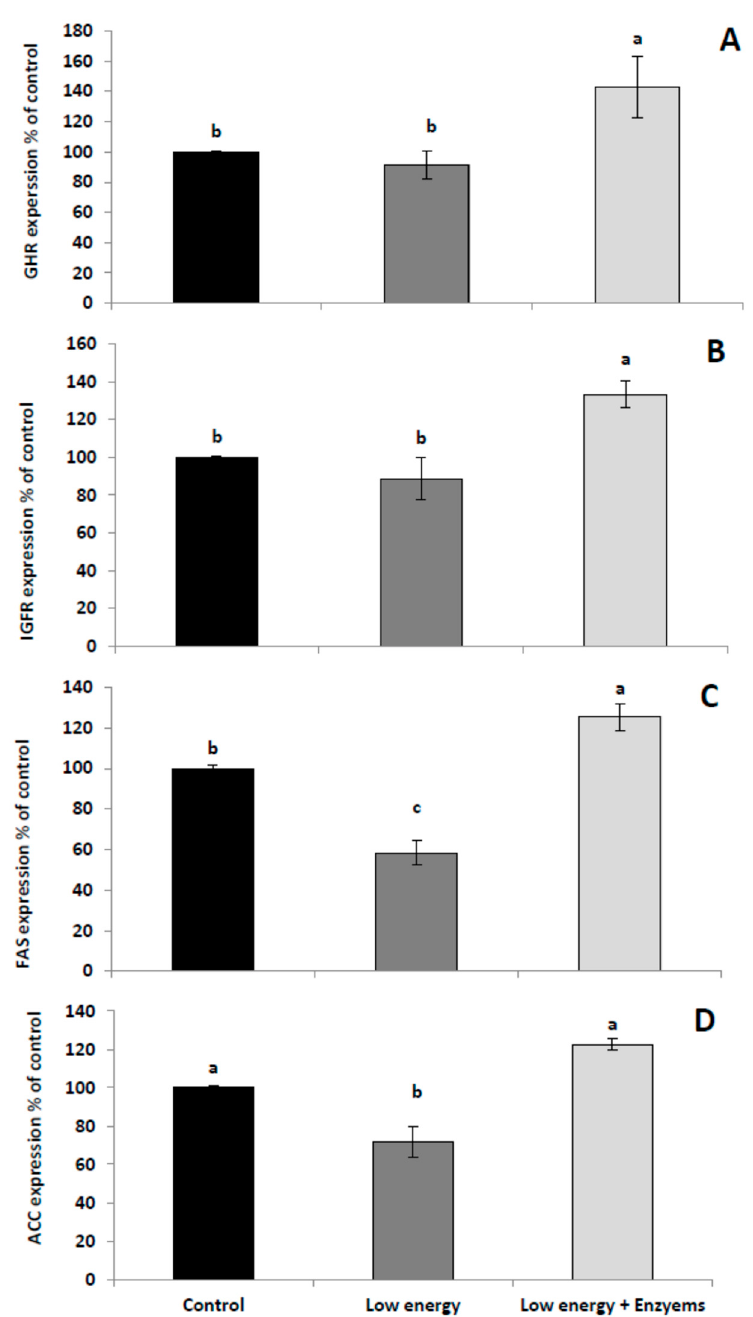
Figure 1. Effect of NSP enzyme supplementation on the gene expression of the growth hormone receptor (GHR) ( A ), insulin-like growth factor receptor (IGFR) ( B ), fatty acid synthesis (FAS) ( C ), and acetyl-coA carboxylase (ACC) ( D ) in broilers. a,b Mean values with different letters in the same column differ significantly at p < 0.05. Values are expressed as means ± standard error. The NSP enzyme used in this experiment was Rovabio® Advance.